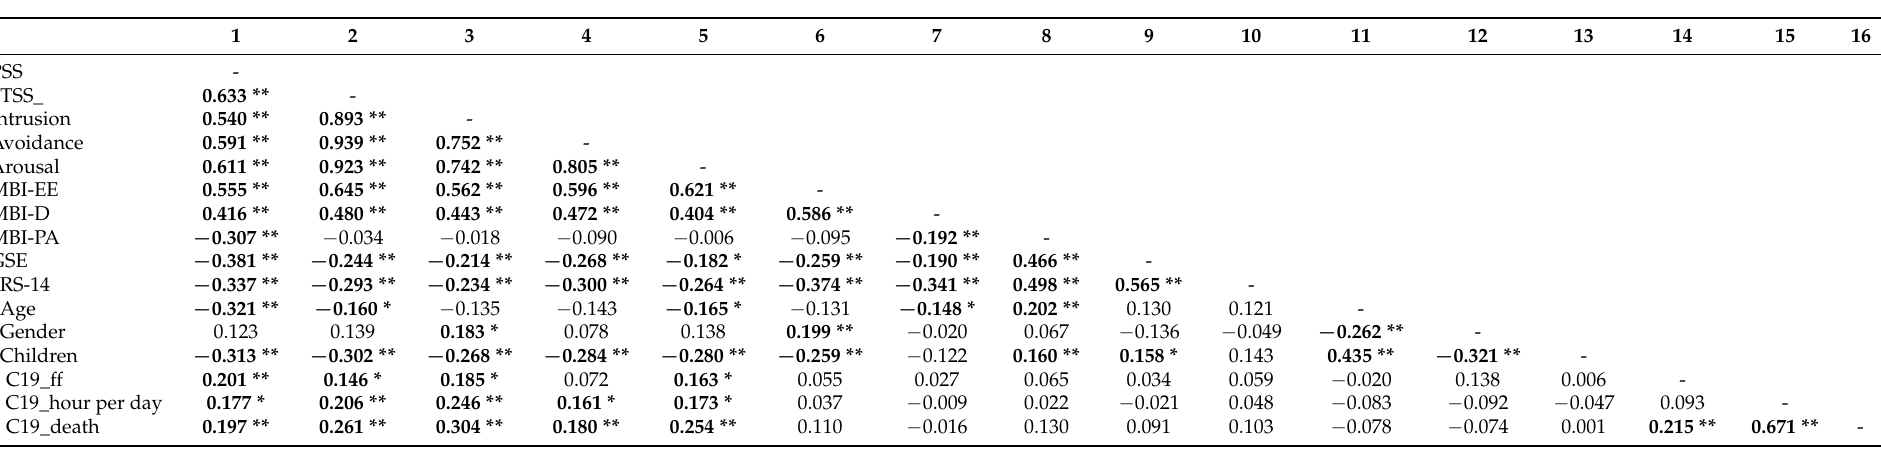
Table 4. Significant Pearson correlation coefficients r: association between perceived stress, secondary traumatic stress, professional burnout, protective factors, demographics, and COVID-19 individual experience in the total cohort (n =